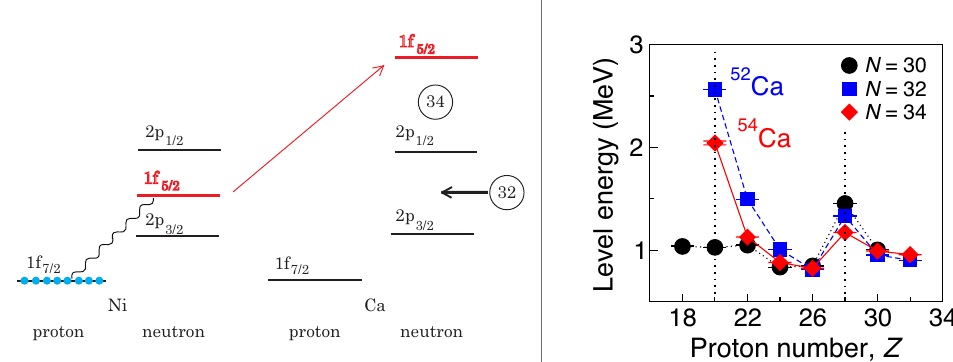
Figure 7. Left : Schematic illustration of the shell evolution from Ni back to Ca for neutron orbits. Blue circles denote protons. The wavy line is the interaction between the proton 1 f 7/2 orbit and the neutron 1 f 5/2 orbit. The numbers in circles indicate magic numbers. Taken from Figure 3 of [24]. Right : Observed excitation energies of the 2 + states. Taken from Figure 2c of 1